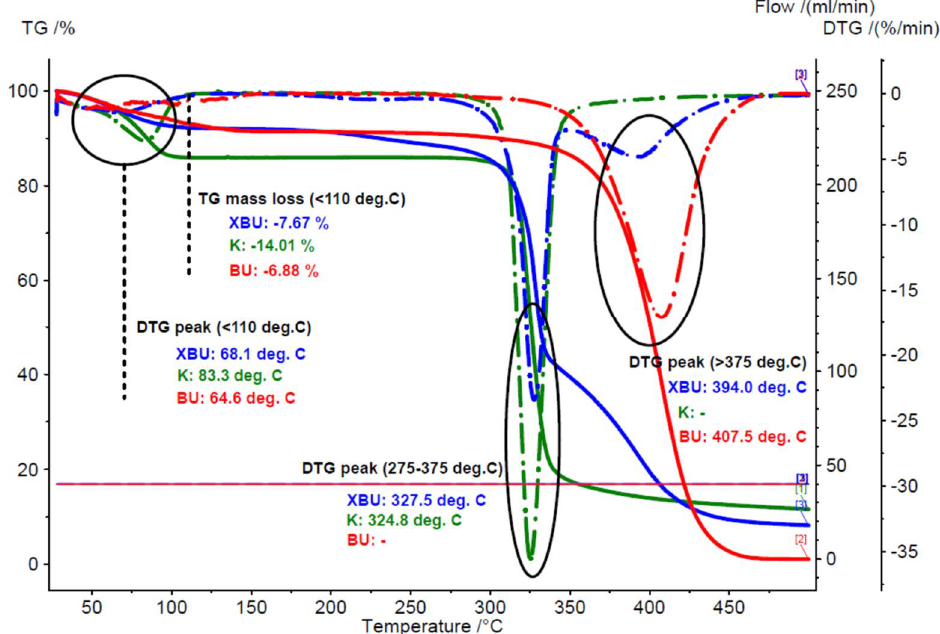
Figure 1. Superimposed TG–DTG thermograms for the β -cyclodextrin/raw breast chicken lipid complex (blue), β -cyclodextrin hydrate (green), and raw breast chicken lipid fraction (red) (codes “XBU”, “K” and “BU”, duplicate samples “a”).